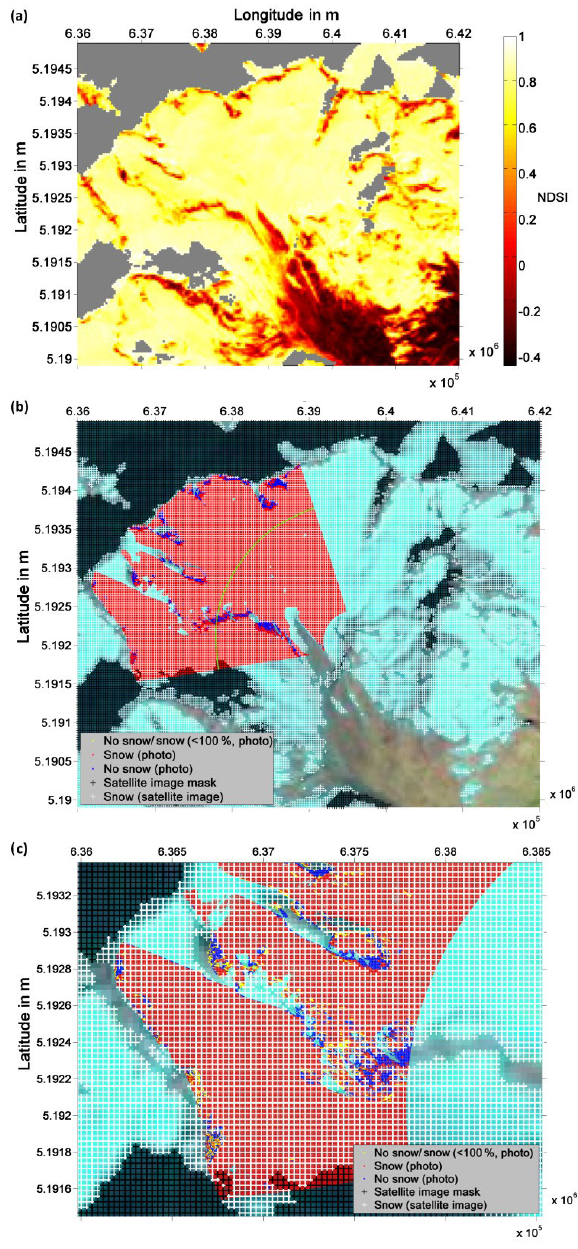
Figure 5. We outline here the internal processing steps within the remote sensing routines of PRACTISE. The Landsat NDSI map from 17 November 2011 is shown in (a) . Clouds and shadows (grey areas) are excluded using Fmask. The photograph and satellite snow cover map derived from the PRACTISE evaluation are superim- posed on the LandsatLook image of 17 November 2011 in (b) . Snow is depicted in red in the photograph snow map and white in the satellite snow map. The lower areas at VF (south-east of the green line in (b) were excluded from the complete analysis. The close-up in (c) clarifies which photographed areas are part of the analysis and additionally underlines the high agreement between photograph and satellite snow cover map. The maps are projected in the Universal Transverse Mercator (UTM) system based on the World Geodetic System 1984